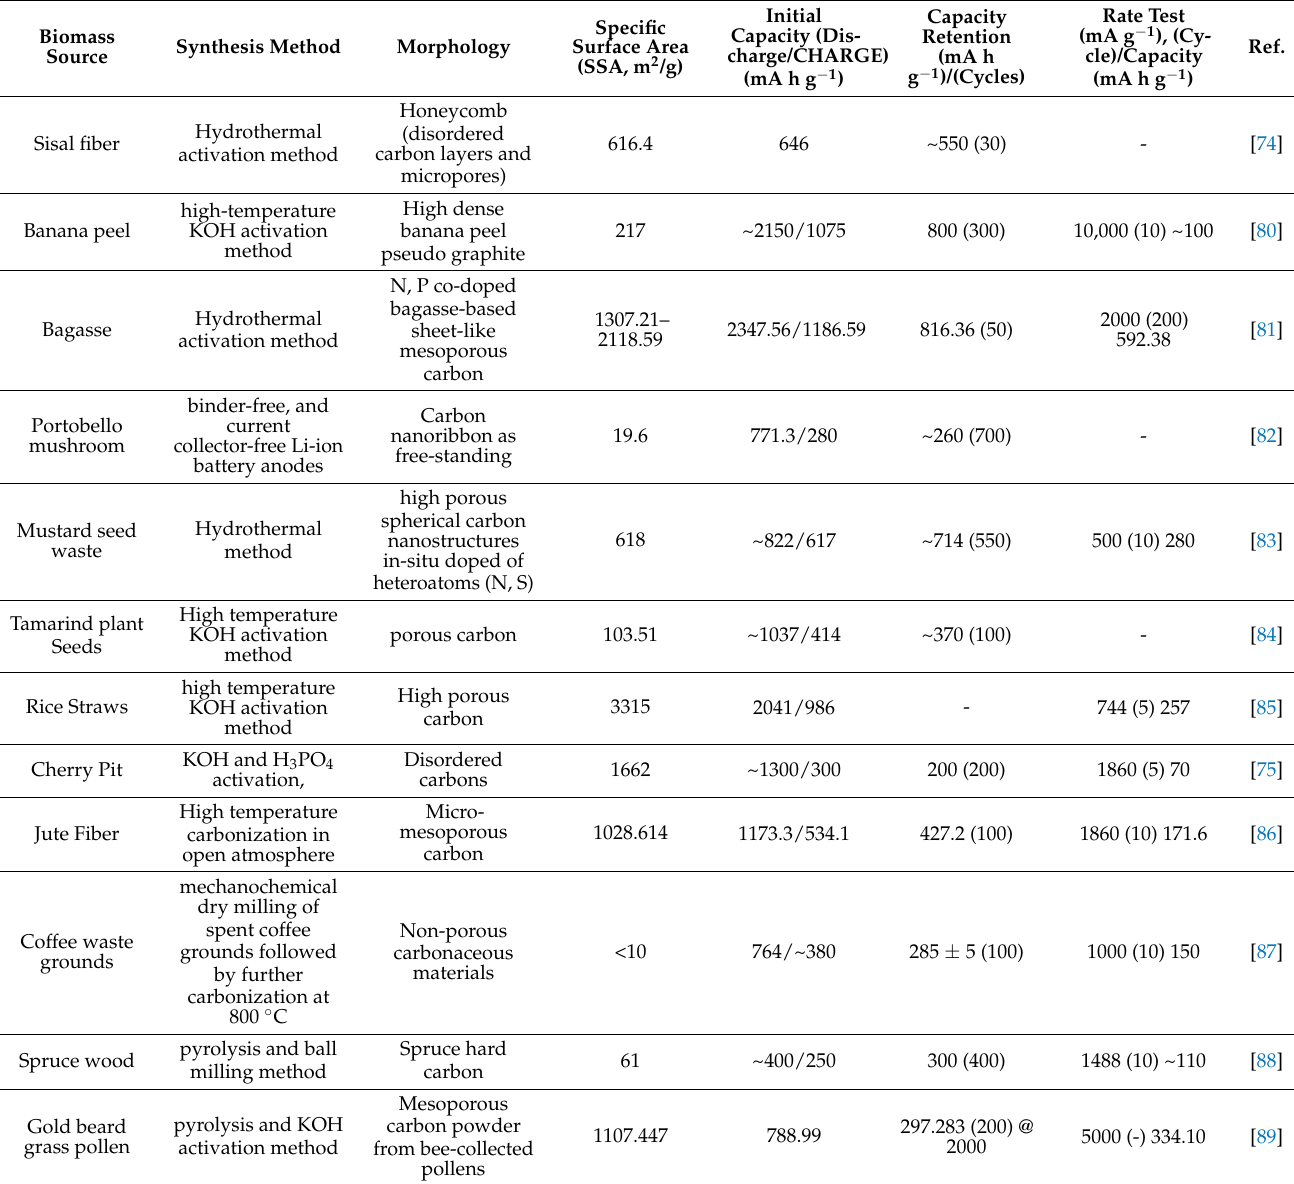
Table 1. Comparative electrochemical performance of biomass-based carbon material anodes for